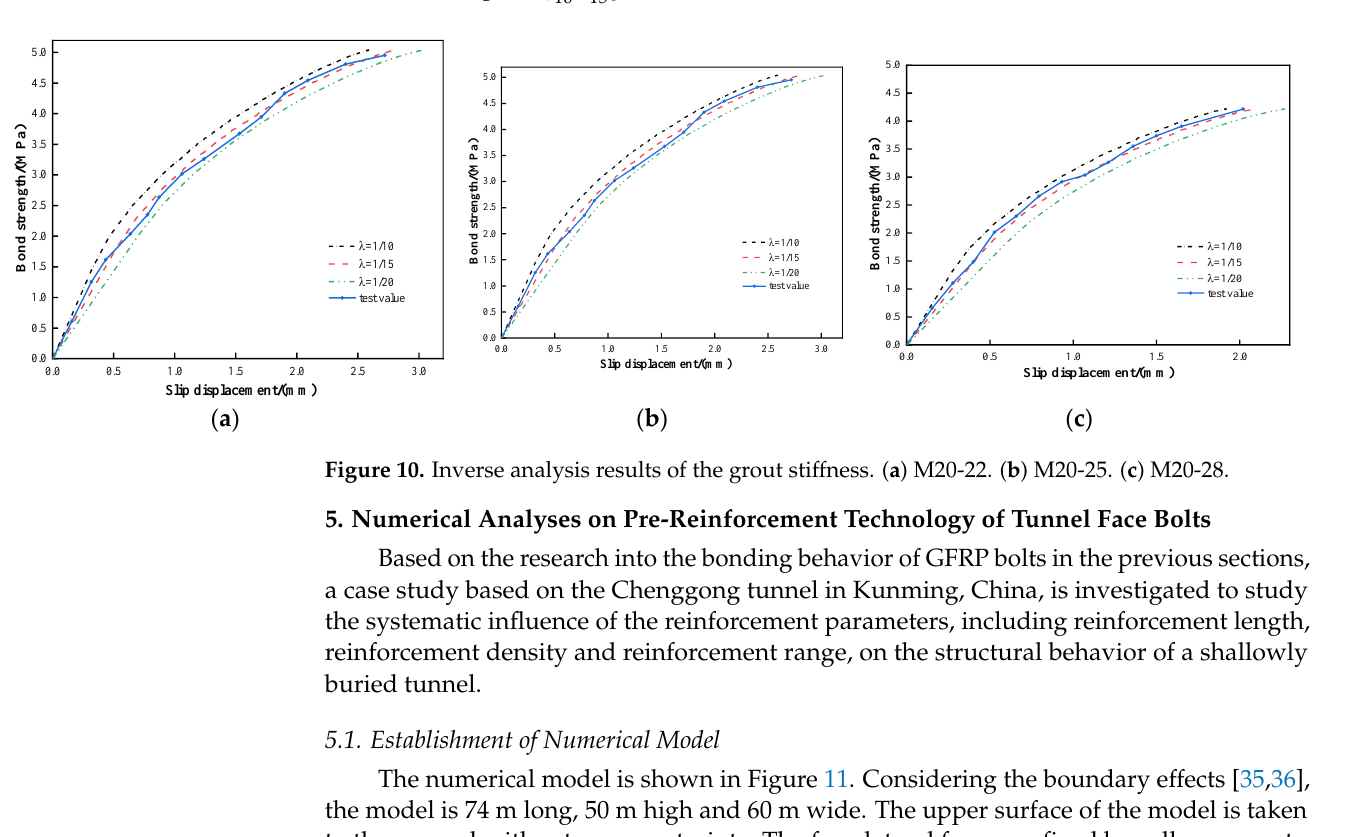
Table 7. Parameters of surrounding rock and initial support.